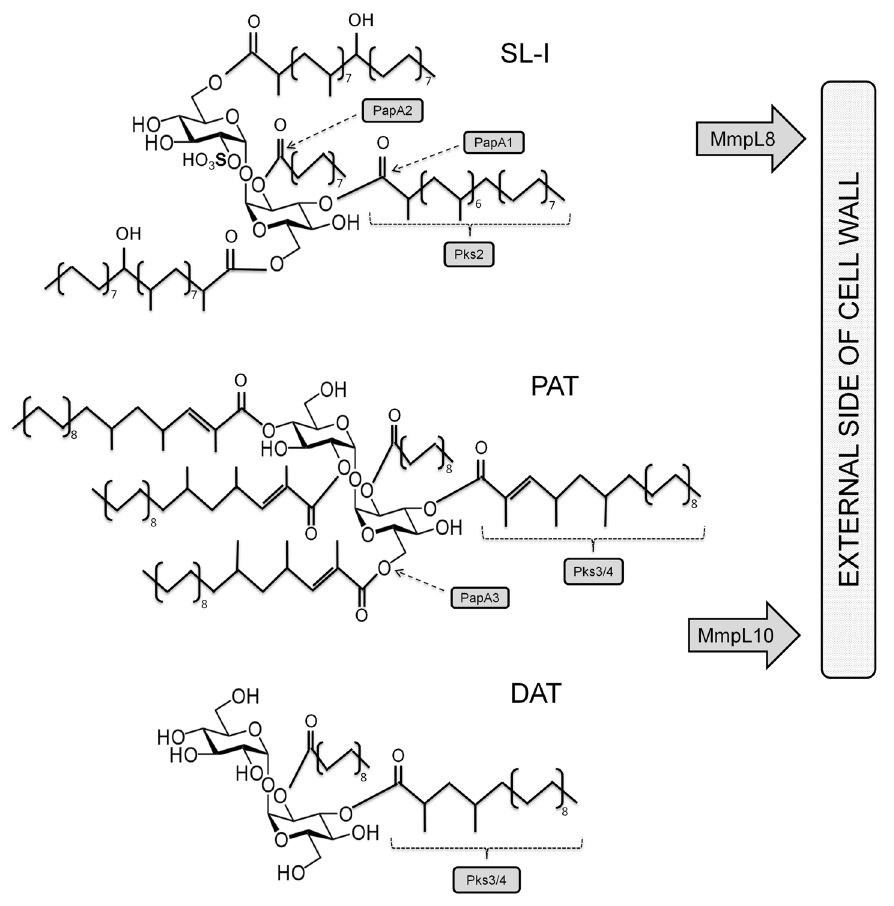
Figure 1. Structure of SL-I and DAT/PAT of M.tuberculosis . The trehalose core is sulphated in position 2 9 and esterified with palmitic, multimethyl-branched phtioceranic and hydroxyphtioceranic acids in positions 2, 4, 6 and 6 9 for SL-I biosynthesis; it is also esterified with stearic and multimethyl-branched mycolipenic acids in positions 2, 2 9 , 3 9 , 4 and 6 9 for PAT, or with mycosanoic acids for DAT biosynthesis. The enzymatic actions of Pks: polyketidesynthase, PapA: acyltransferases and MmpL: mycobacterial membrane protein-large polyketide transporters are shown by dashed lines and arrows.